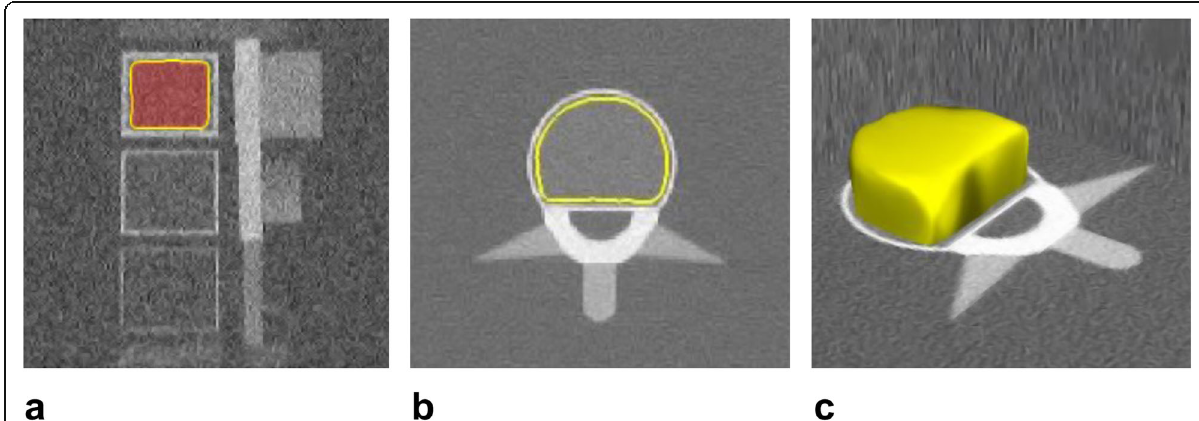
Fig. 2 a The European spine phantom contains three different inserts with different nominal design concentrations of 50, 100, and 200 mg/cm 3 HA for L1, L2, and L3, respectively. By application of specific software features for labeling of HA inserts (LiverLab; Fraunhofer Institute for Computer Graphics Research, Darmstadt, Germany), the trabecular bone (red area) was marked manually (yellow line). b Exemplary axial image of one HA insert showing the trabecular VOI (yellow line). c Three-dimensional reconstruction of the VOI which is depicted as a yellow formation. This VOI and the two DECT series (90 and Sn150 kVp) served as input for volumetric bone mineral density assessment using a second software tool (BMD Analysis; Fraunhofer Institute for Computer Graphics Research, Darmstadt, Germany), which works on material decomposition. HA, Hydroxyapatite; L, Lumbar vertebra equivalent; VOI, Volume of interest; DECT, Dual-energy computed tomography; BMD, Bone mineral